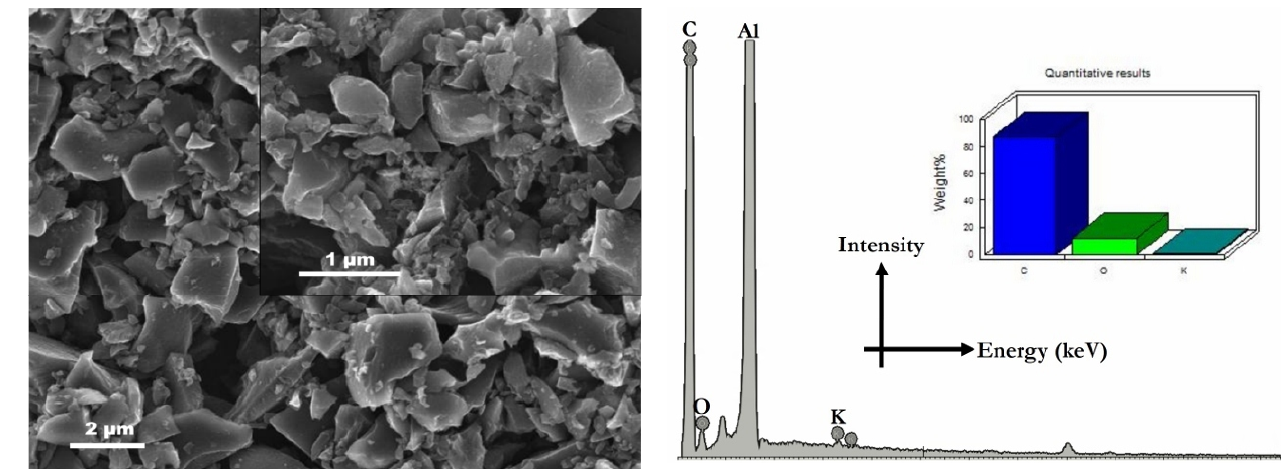
Figure 3: EDX analysis of pyrolyzed and ground coconut shells particles.